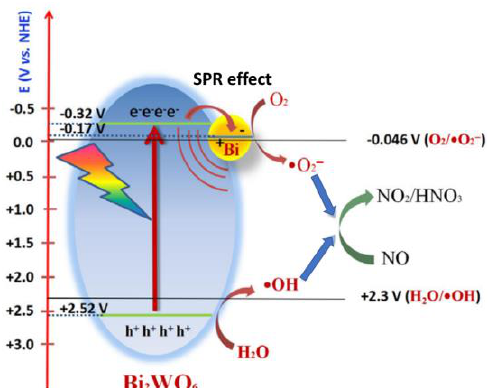
Figure 9. Schematic illustration of the SPR effect on the enhanced photoreactivity of Bi 2 WO 6 toward NO oxidation after being loaded with Bi nanospheres. Reproduced with permission from [63]. Copyright 2019 Elsevier.